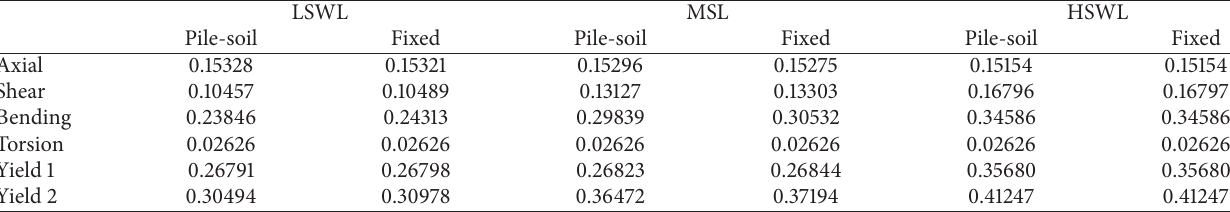
Table 16: Member unity checks for irregular wave.